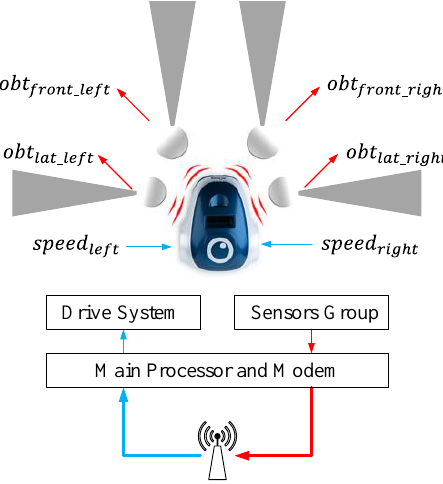
Figure 4. General structure of the differential wheeled robots.